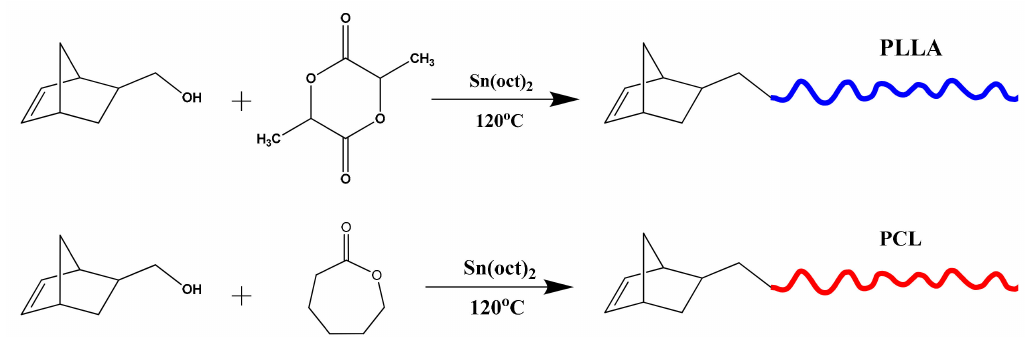
Figure 1. Synthesis of NBE-PLLA and NBE-PCL macromonomers.